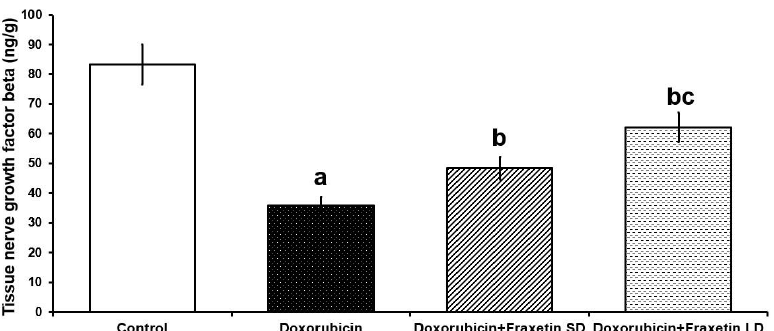
Figure 3. Effect of the different doses of fraxetin on nerve growth factor beta of the cardiac tissues in doxorubicin-treated rats (Mean ± SD). a Significant relative to the control group ( p -value less than 0.05); b Significant relative to doxorubicin group ( p -value less than 0.05); c Significant relative to doxorubicin + fraxetin small dose group ( p -value less than 0.05).